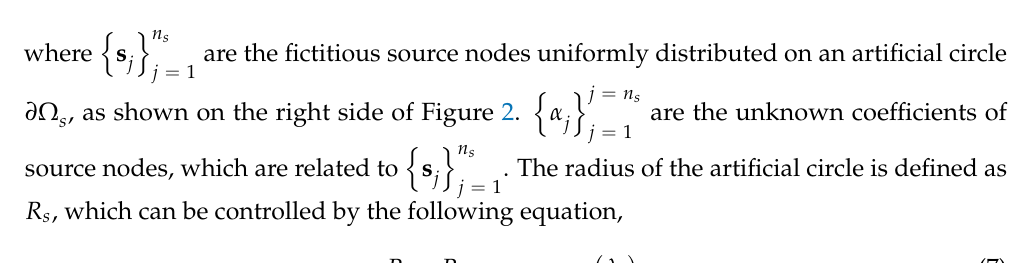
. Figure 2. Schematic of a local domain Ω s s